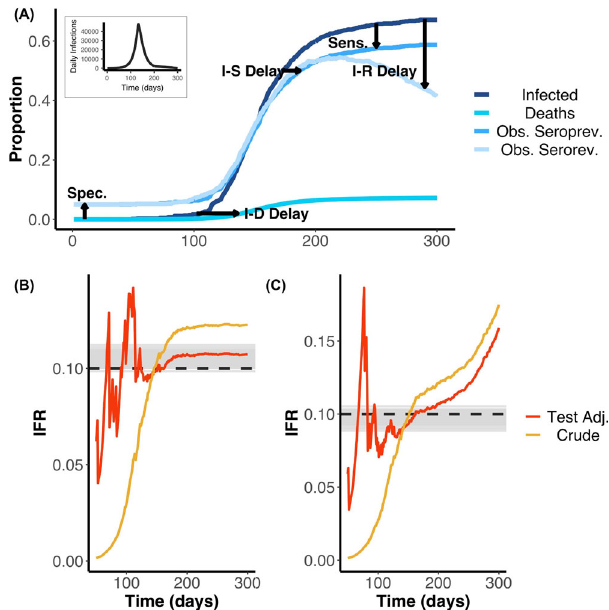
Fig. 1 IFR estimates from serologic data. A Schematic showing cumulative infections, deaths and seroprevalence with and without seroreversion over time. We highlight the effects of delays from infection to seroconversion (I – S Delay), to death (I – D Delay), and to seroreversion (I – R Delay) as well as serologic test sensitivity (Sens.), serologic test speci fi city (Spec.) on the observed data. The daily infection curve used as input for the simulation is shown as the plot inset. Early in the outbreak, false positives dominate due to low prevalence and imperfect speci fi city, whilst later the difference between true cumulative incidence and observed seroprevalence is mainly due to low sensitivity and/or seroreversion. The delays show how the cumulative infection curve is lagged behind the observed seroprevalence. Similarly, the contrast of the seroprevalence curve with (Obs serorev) and without (Obs seroprev) seroreversion reveals the loss of sensitivity over time. These simulations were used as the inputs for the results displayed in ( B , C ). We used 0.1% of the simulated data at random (i.e. we do not assume we observe the entire population through time). B Estimated IFR over time based on a simulated epidemic that does not include seroreversion. Here, the simulated IFR value is indicated by the dashed black line and the grey lines indicate 100 posterior draws from the fi tted statistical model (based on the posterior probability), indicating the capacity for our model framework to correctly recover the true IFR. Red and yellow lines represent the simple and test-adjusted (Rogan-Gladen correction) IFR estimates (see Main Text), calculated as if the serosurvey had been conducted on each respective day (after day 50). In the case without seroreversion, the IFR appears to be adequately captured by the Rogan-Gladen correction once infections have stopped accruing (the realised IFR appears to be slightly greater than the initial simulated true IFR value of 0.1). C As for ( B ), but the simulation and statistical model both include seroreversion. The IFR values are shown as a probability. In the case that includes seroreversion, the Rogan-Gladen correction can no longer adequately capture the IFR value, as seroprevalence estimates are constantly changing. In addition, in the outbreak, when the true seroprevalence is less than the false positive rate, adjusting for the serologic test characteristics can result in unstable IFR